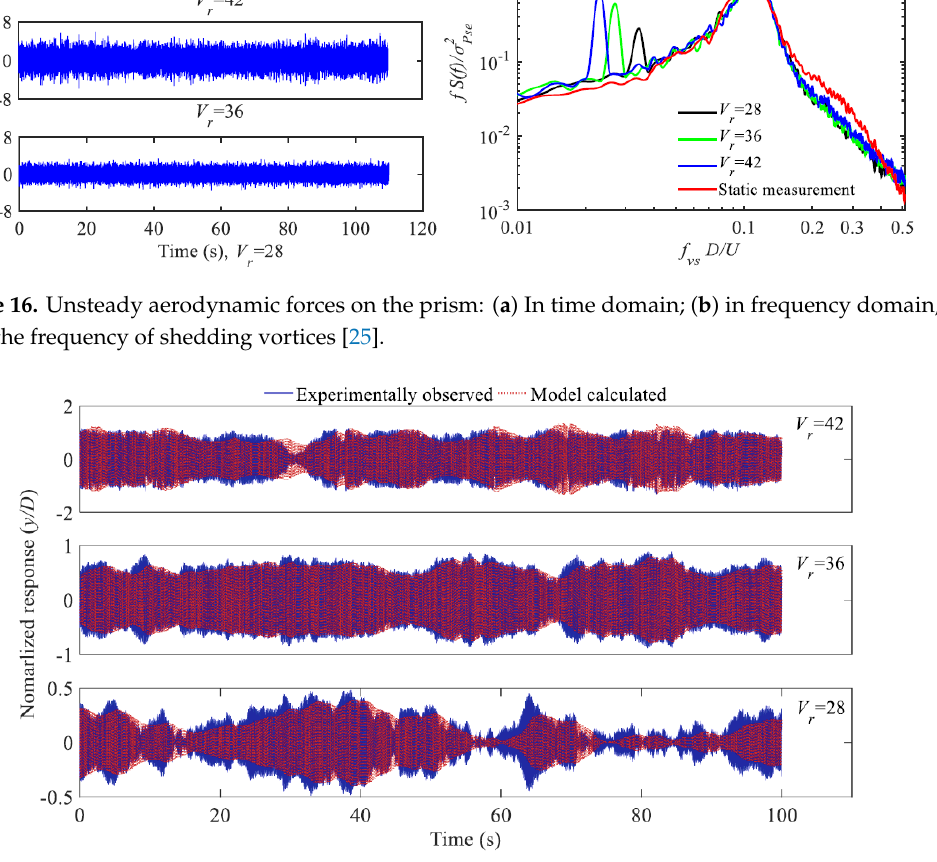
Figure 17. Comparison between the calculated and measured amplitudes of galloping instability [25].